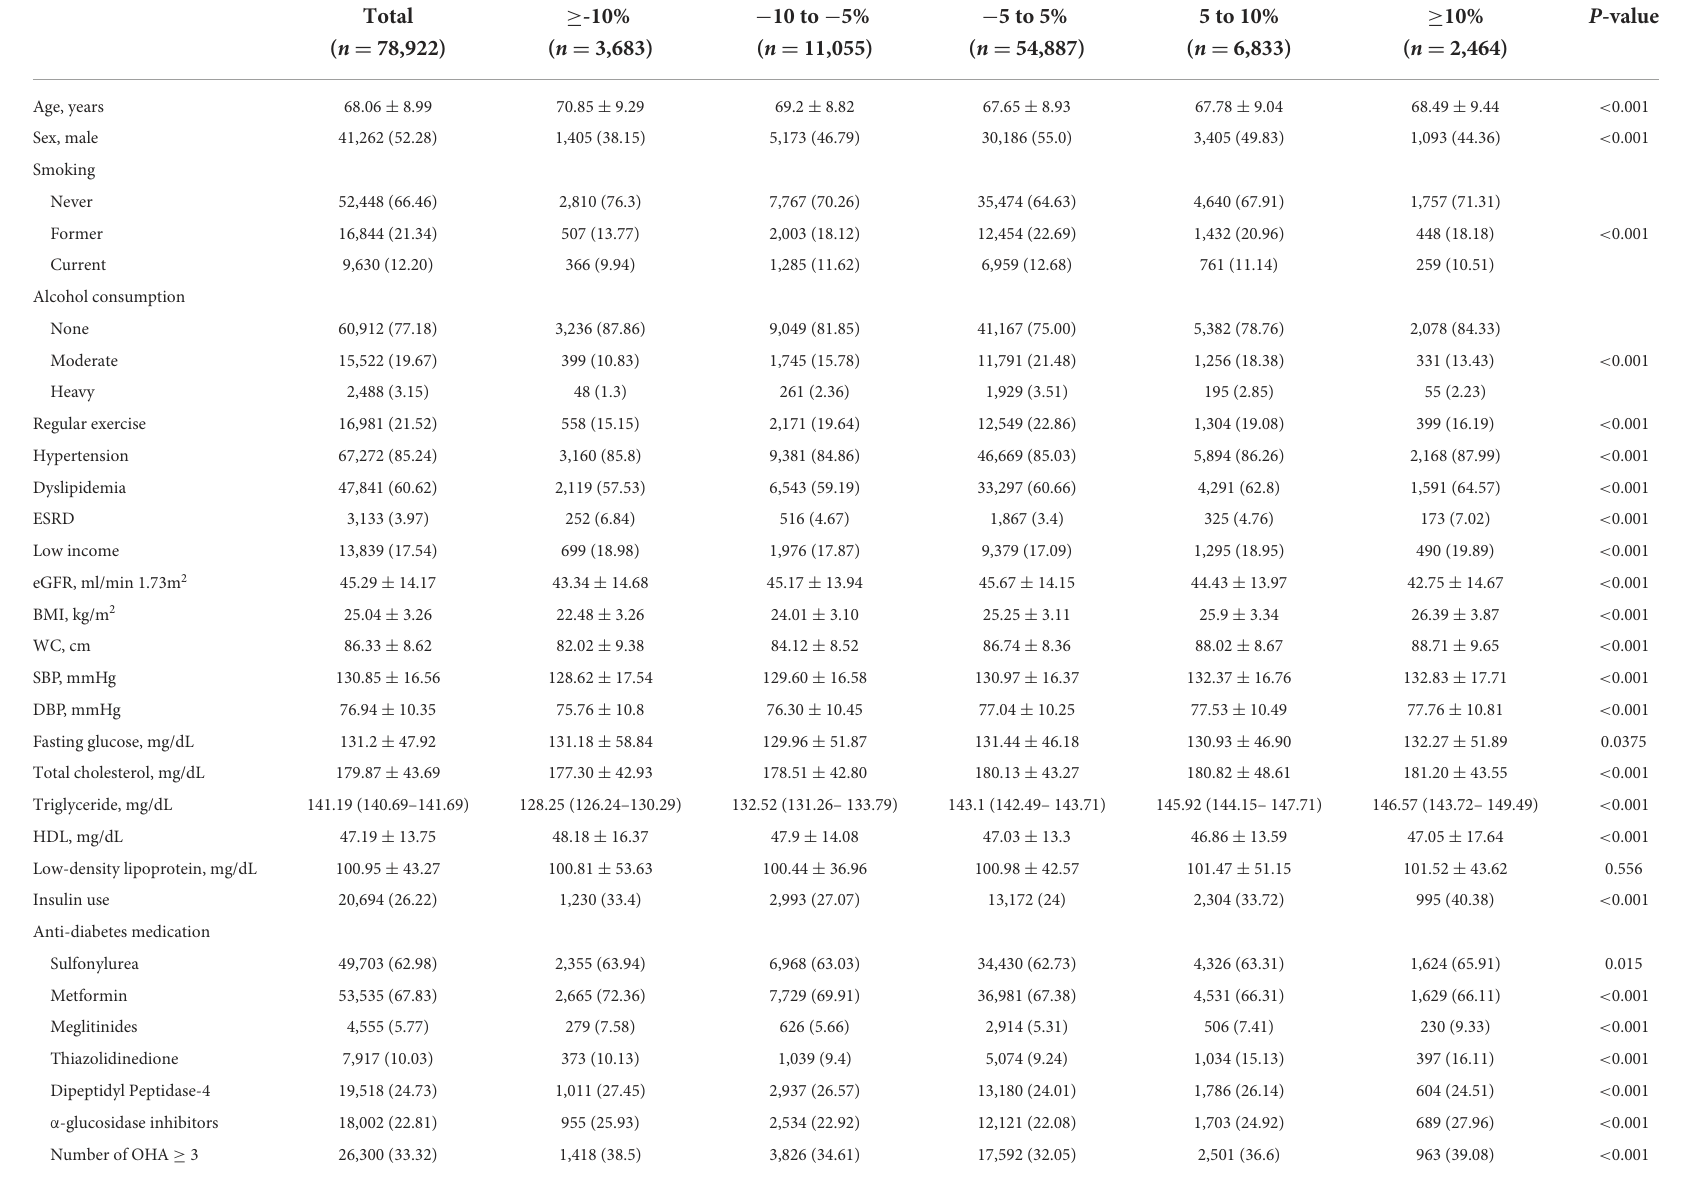
TABLE 1 Baseline characteristics of the study population according to the status of weight changes.